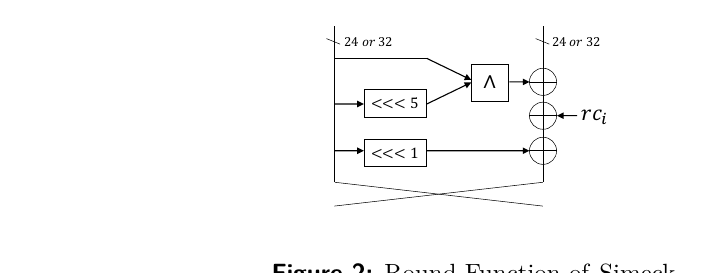
Figure 2: Round Function of